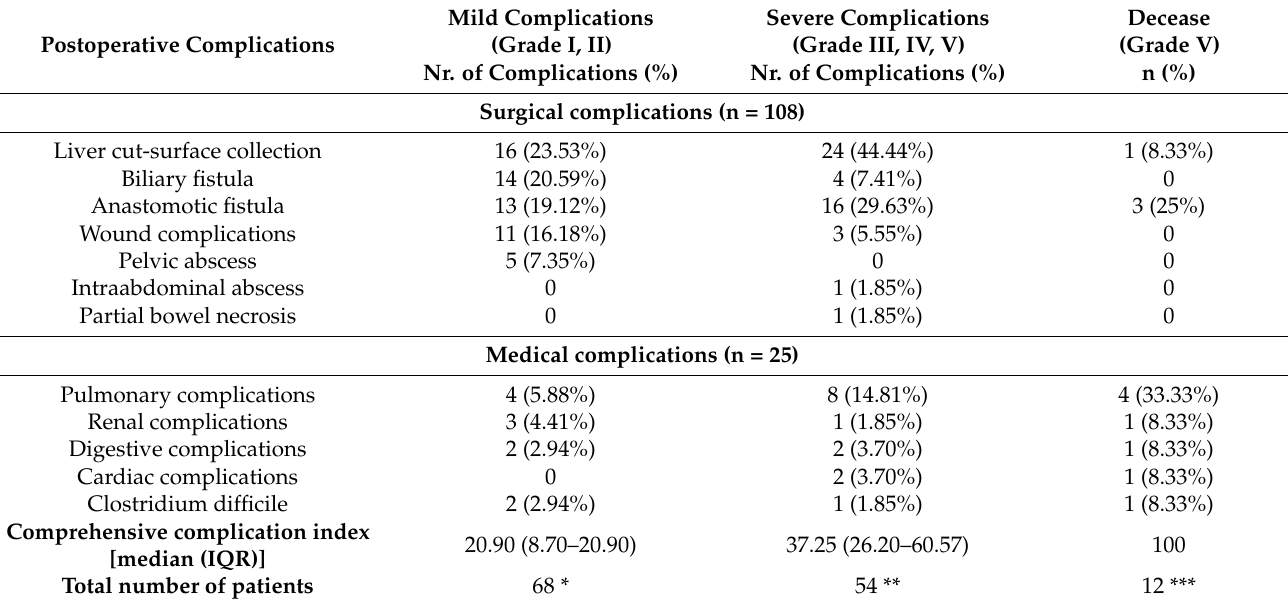
Table 2. Postoperative complications according to Clavien–Dindo